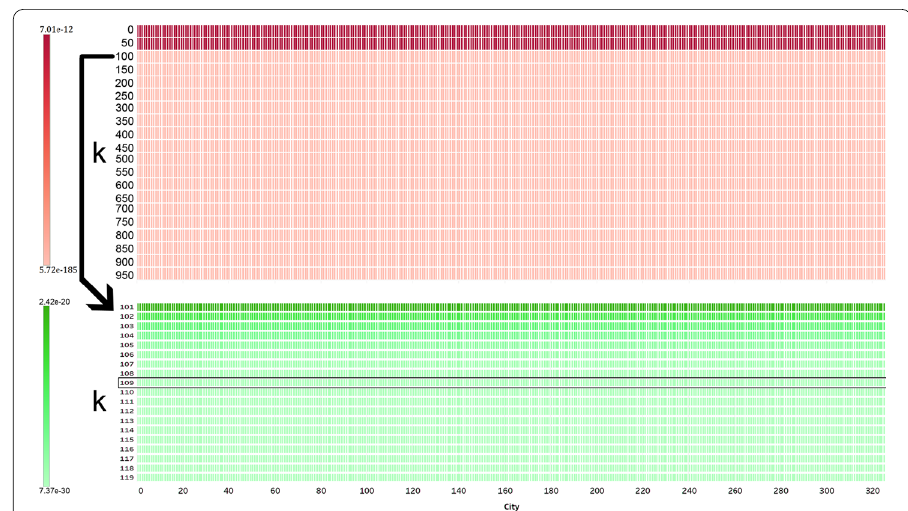
Figure 10 After setting (cid:3) to 5%, approximation errors depend on the number of pivots k ( y -axis) and the number of nodes n , which varies across cities ( x -axis). We found that the choice of city did not have a noticeable impact. Approximation error became small in the range 100–150 (top), and we chose k = 109 (bottom; framed). Due to the wide range of values, note that scales (i.e. colormaps) are